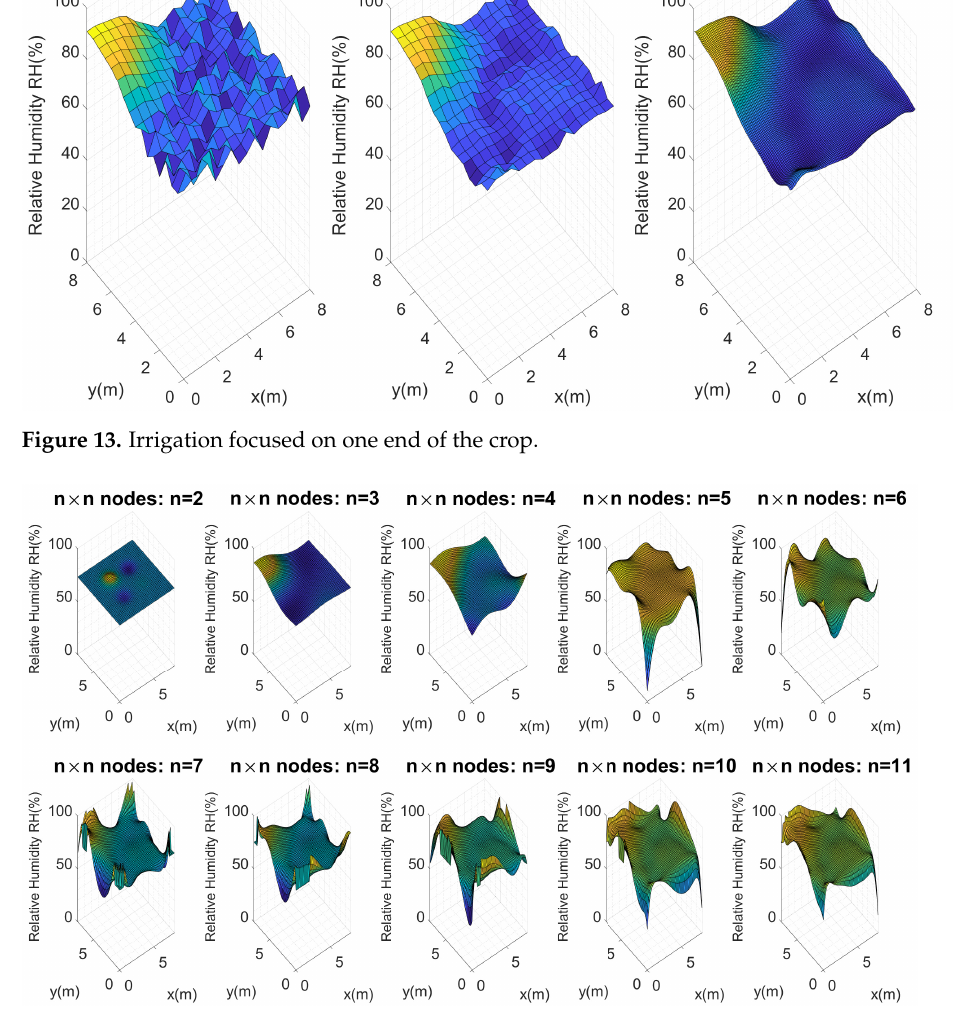
Figure 14. Soil moisture distribution maps in the test crop using n × n nodes. Second experimen- tal test.